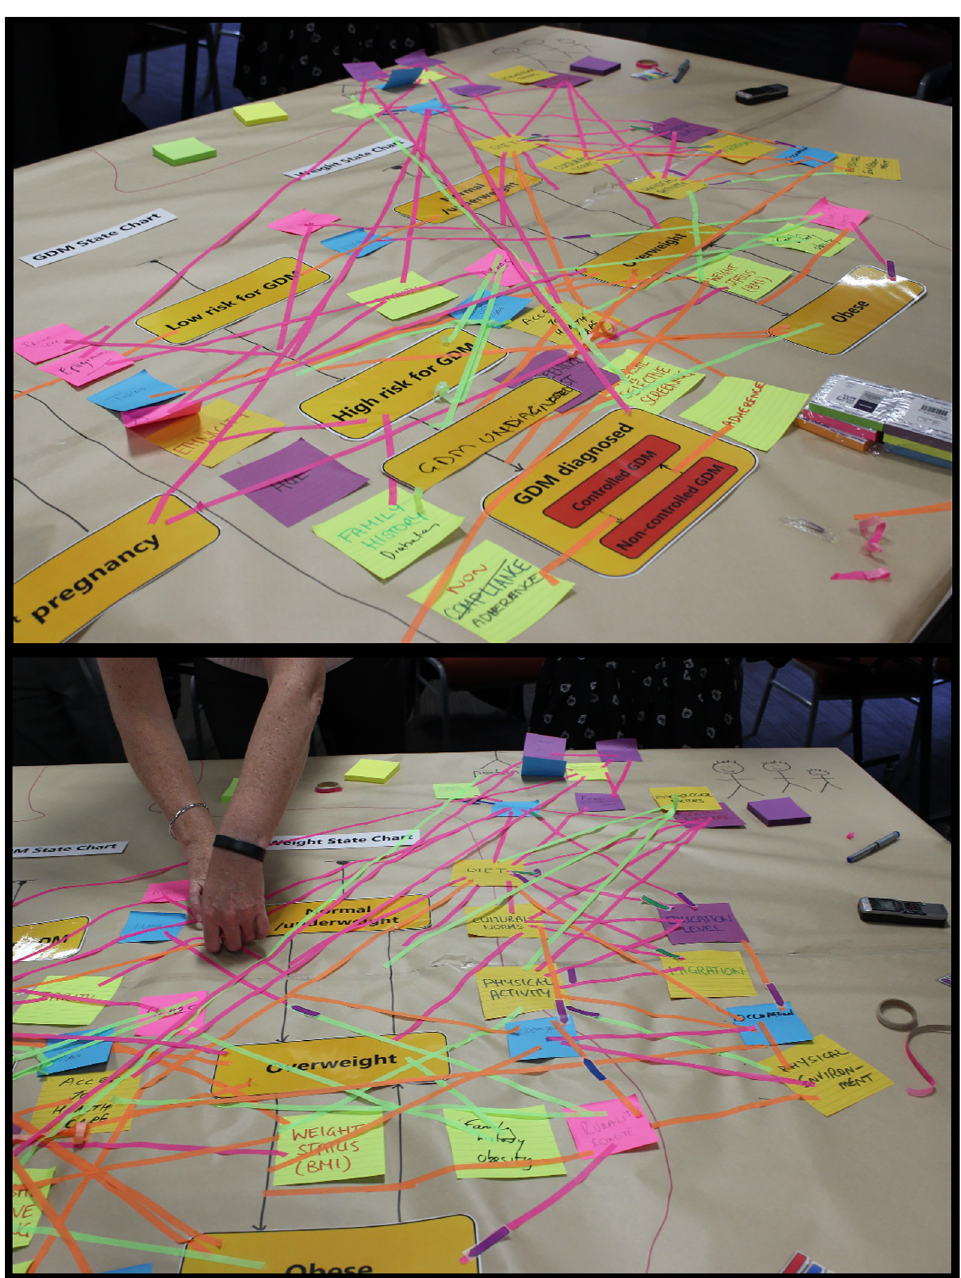
Fig 3. Problem conceptualisation map from participant workshop 1